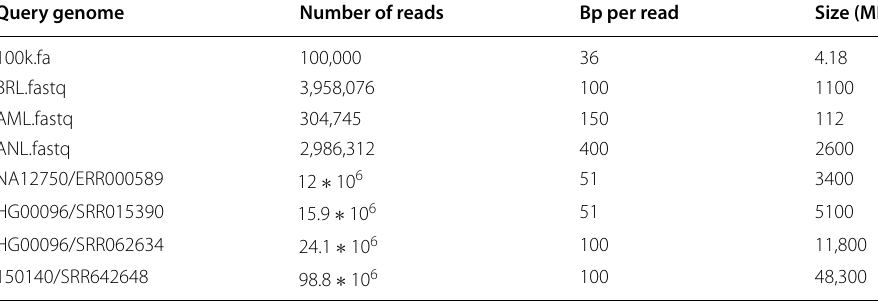
Table 1 Query datasets